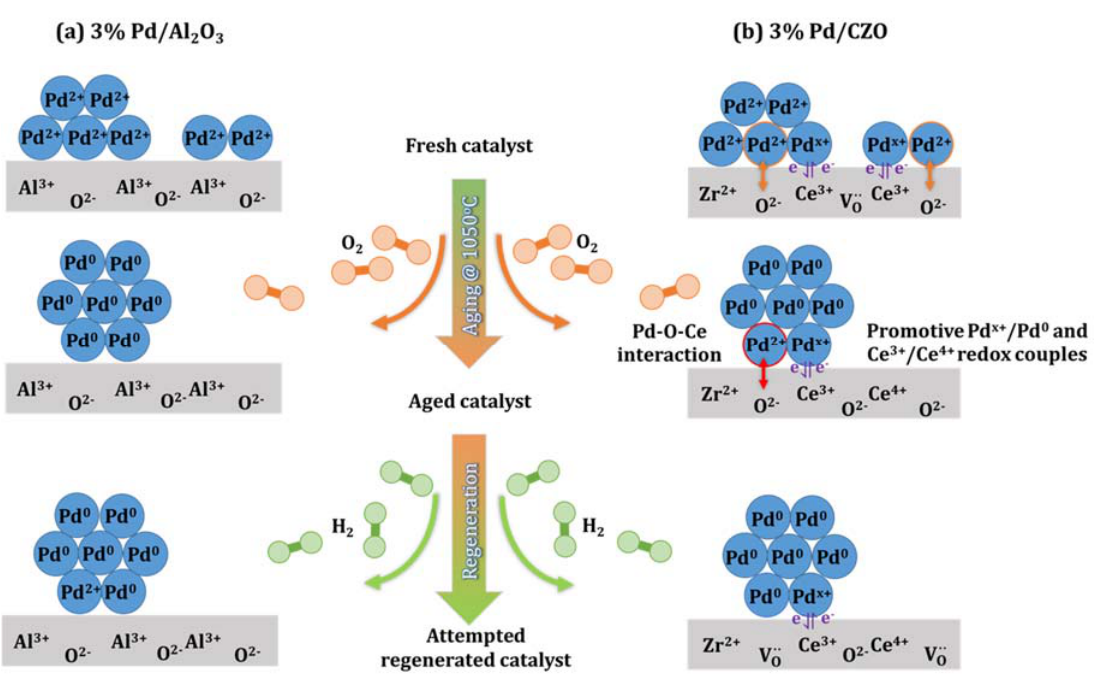
Figure 11. Schematic of proposed model for deactivation and regeneration of 3% Pd/Al 2 O 3 and 3% Pd/CZO during simulated fuel shutoff aging (1050 °C) and fuel rich regeneration (550